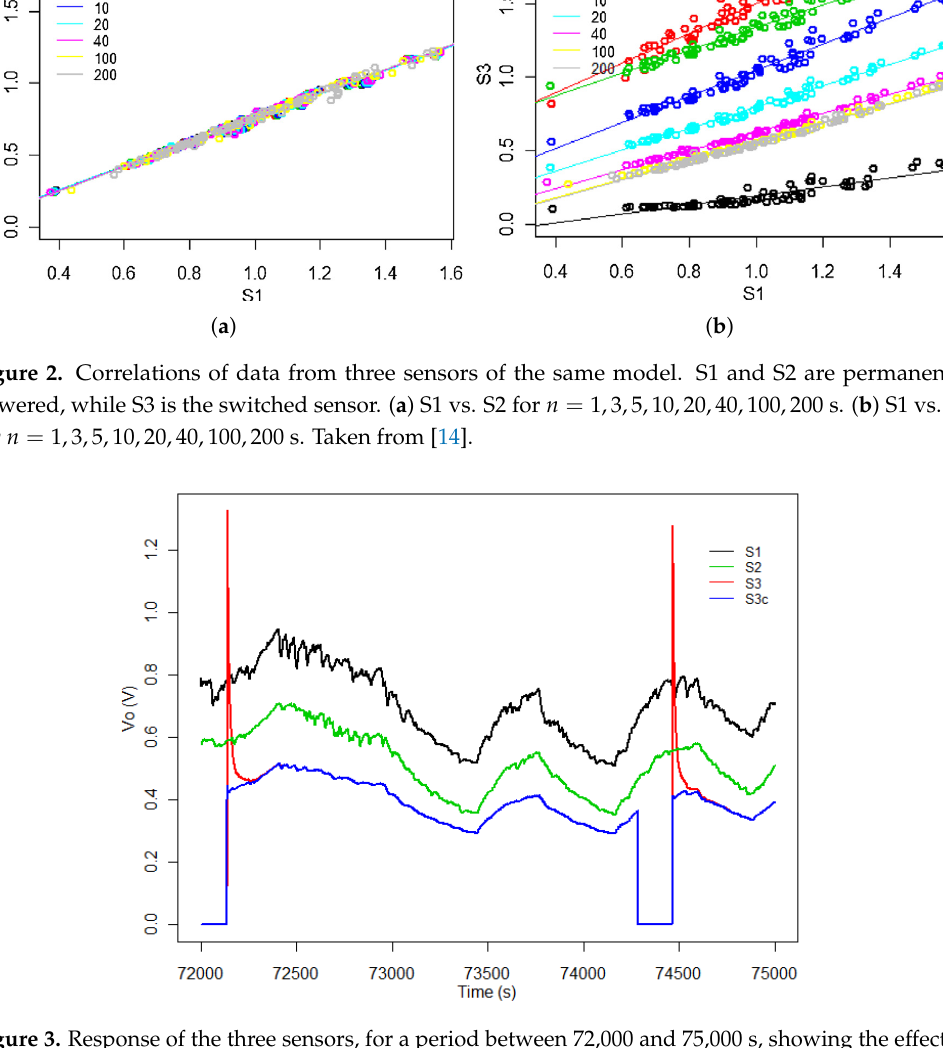
Figure 3. Response of the three sensors, for a period between 72,000 and 75,000 s, showing the effect of the application of the method described in